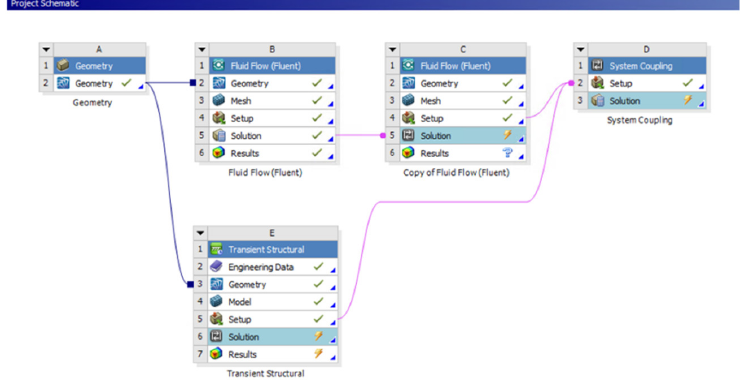
Figure 11. The schematic projects included in the TLD + OWT interaction simulation.